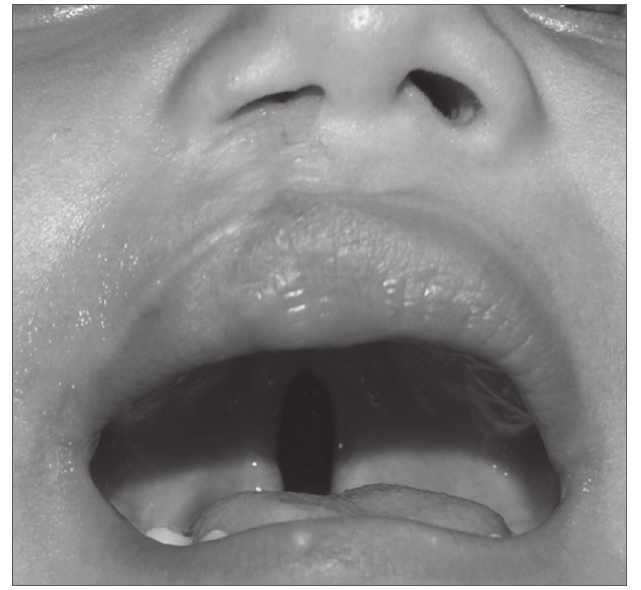
Figura 1. Paciente com fissura labial direita incompleta associada à fissura palatina incompleta. Observa-se que já foi realizada a correção cirúrgica da fissura labial.